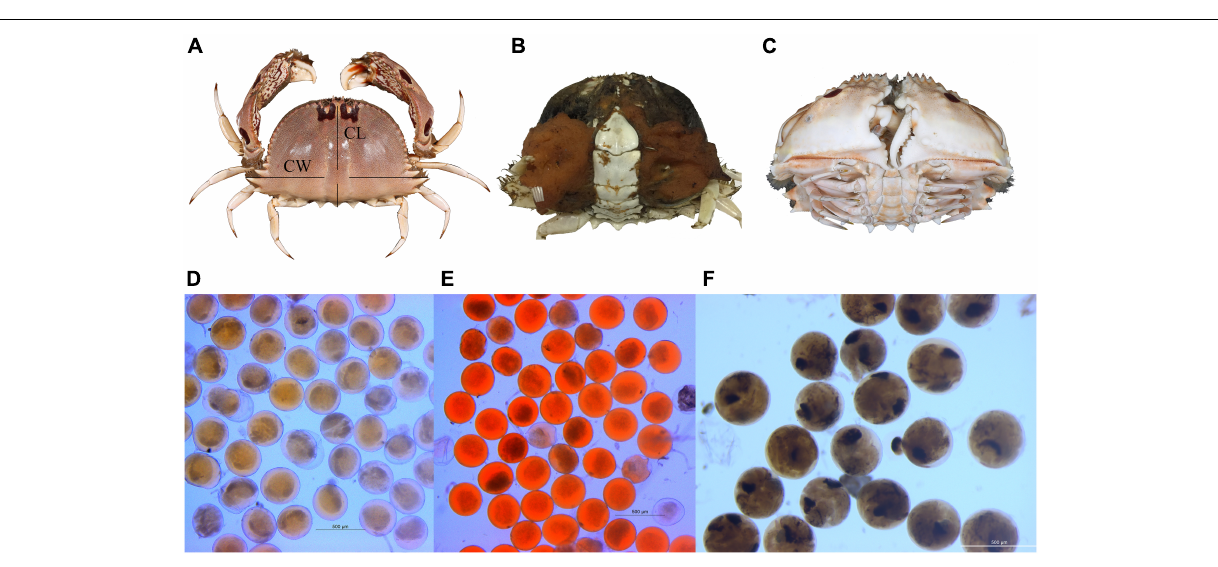
FIGURE 2 | (A) Dorsal view of Calappa philargius for carapace width (CW) and carapace length (CL) measurements. Sex determination by abdomen morphology: (B) female and (C) male. (D) Yellow eggs, (E) orange-red eggs and (F) brown eggs measurement under a